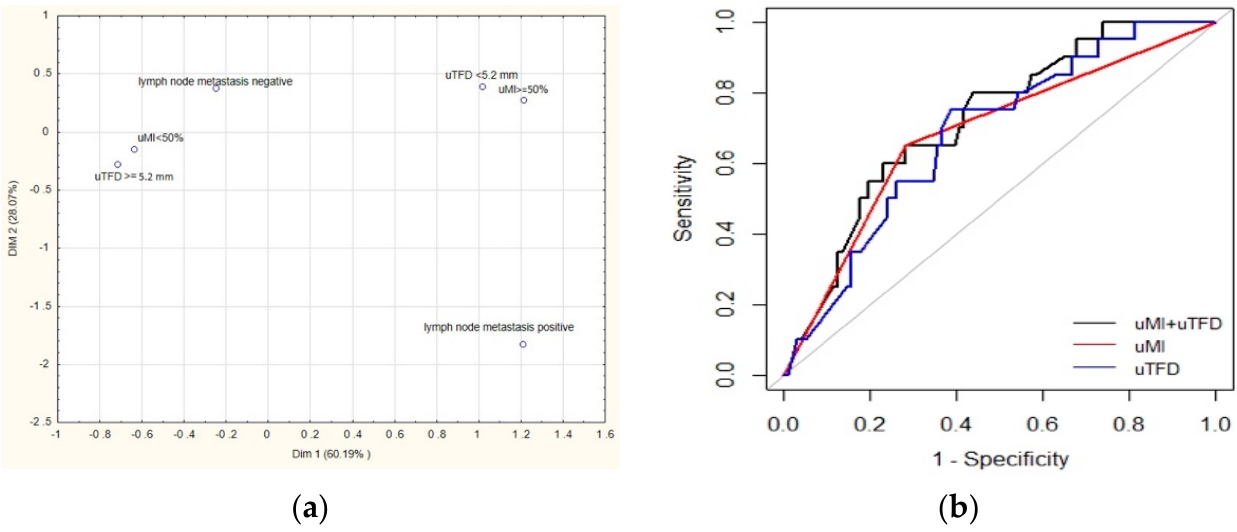
Figure 2. ( a ) Multiple correspondence analysis of ultrasound biomarker status and lymph node. ( b ) Presents the associations between ultrasound parameters and risk groups (ESGO 2012, due to the existence of this risk stratification during the study). There was a statistically significant association between uMI and uTFD and risk groups (Figure 3a,b).